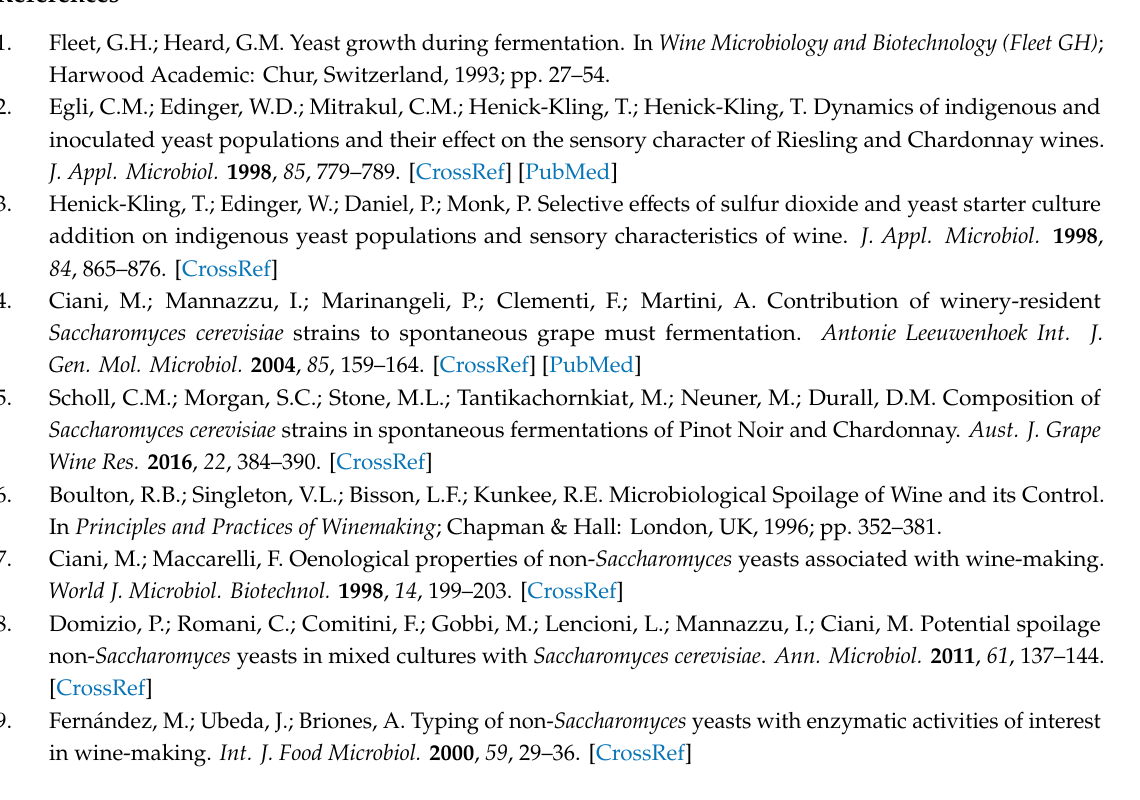
Figure S1: Phenotypic profile of the S. ludwigii UTAD17; Table S1: Comparative analysis of the predicted S. ludwigii UTAD17 ORFeome with sets of proteins of S. cerevisiae